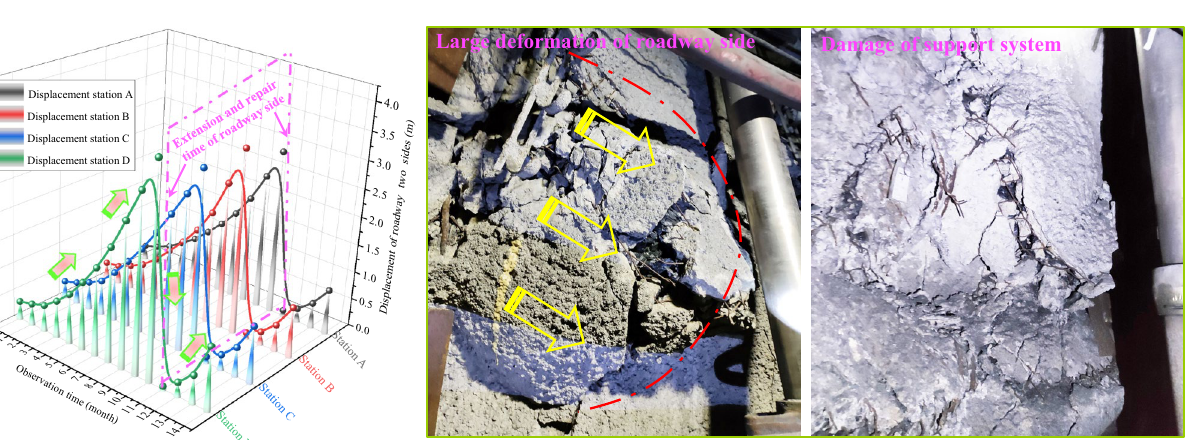
Figure 5. Deformation curve of each measuring station without panel advance turbulence and deformation on site.